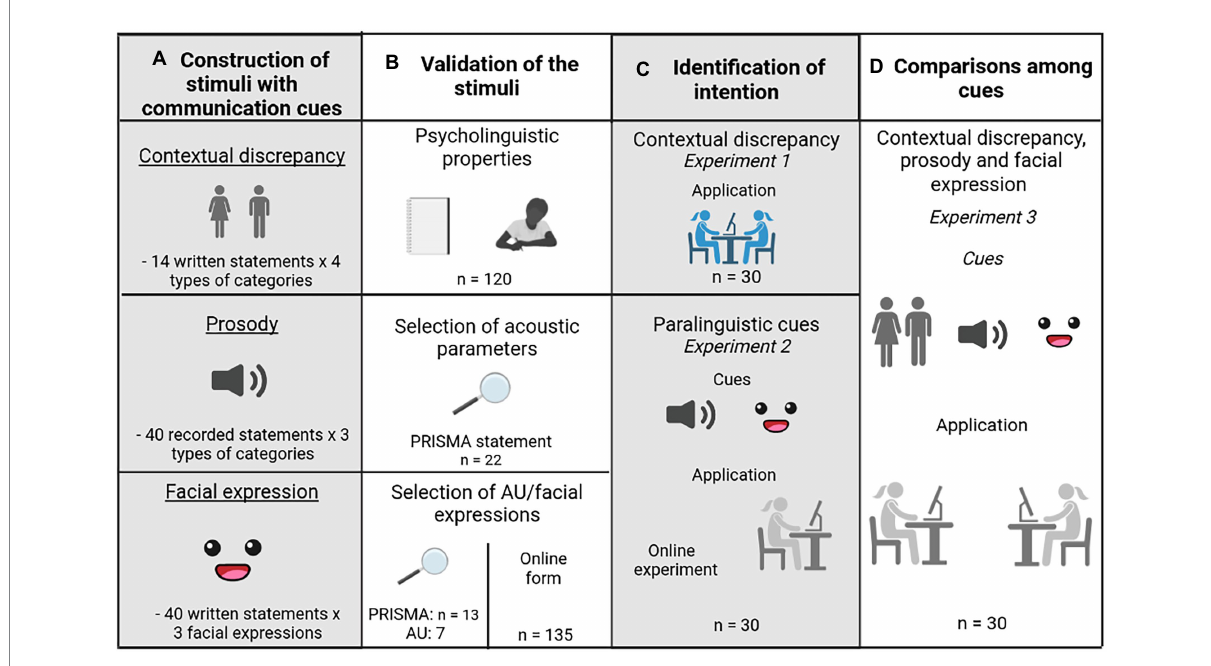
FIGURE 1 Graphical depiction of the experimental procedure. Columns show the phases of each experiment and rows depict the cues that were evaluated (i.e., contextual discrepancy, prosody and facial expression). Details about each step are available in their respective sections. AU = Action